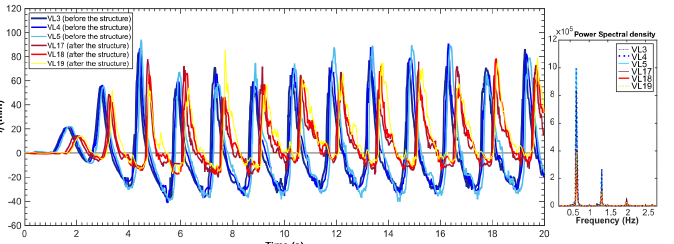
Figure 10. Comparison of water elevations ( η ) measured by three consecutive virtual level (VLs) sensors placed before the structure (VL3, VL4, and VL5) with three consecutive VLs located after the structure (VL17, VL18, and VL19), including the power spectral density of the signals.